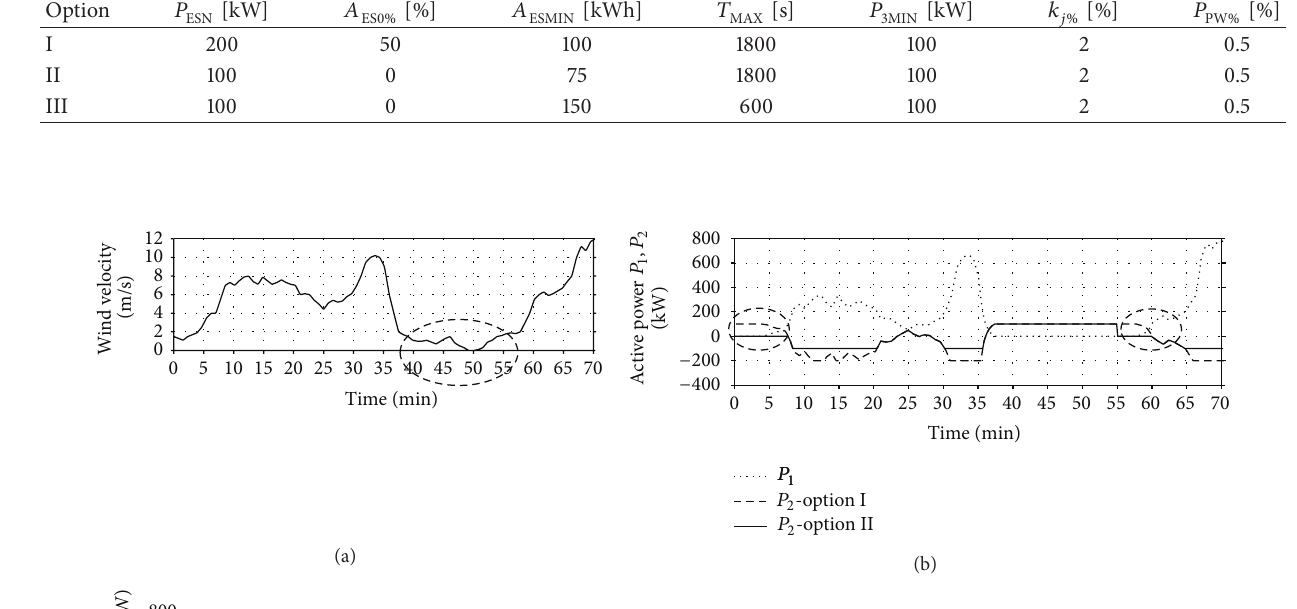
Figure 11: Courses of changes in WT-FESS parameters obtained in the developed simulator for the test input V II of calculations (Table 4): (a) wind velocity V